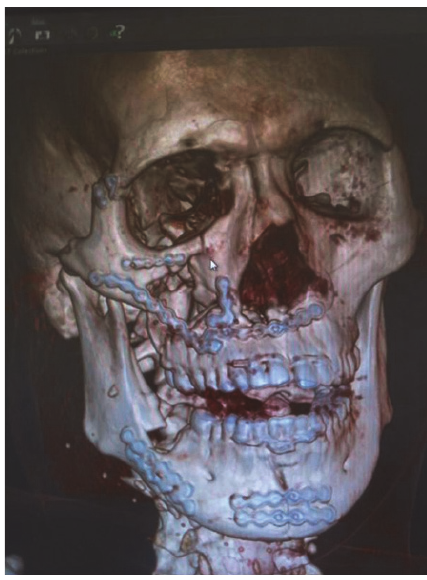
Figure 6: Postsurgical 3D CT